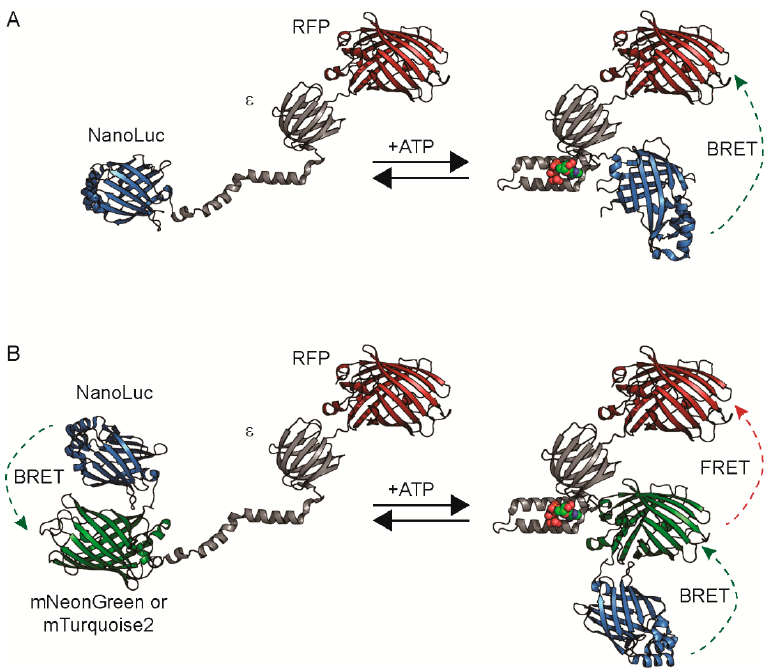
Figure 1. Sensor designs. Diagrams of a bioluminescence resonance energy transfer (BRET)-only sensor ( A ) or BRET-FRET (Förster-type resonance energy transfer) sensor ( B ) depict NanoLuc in blue, the B. subtilis ε subunit in grey, an RFP (red fluorescent protein) in red, and either mNeonGreen or mTurquoise2 in